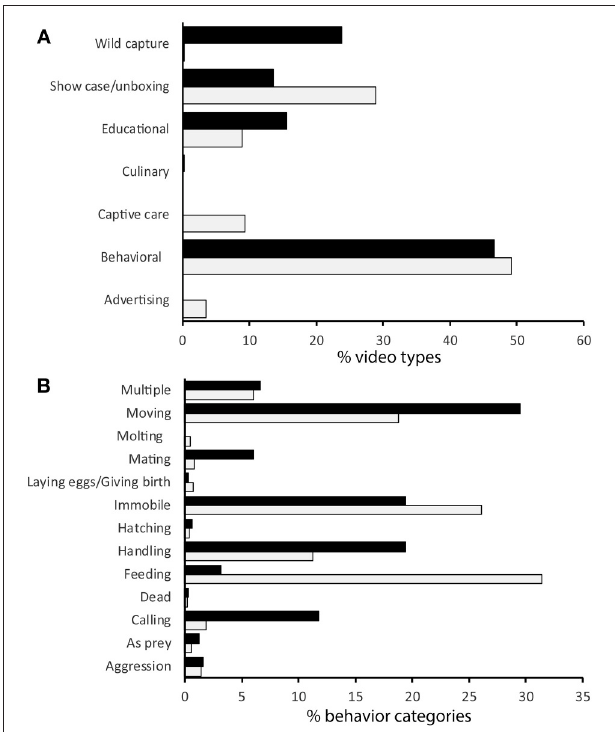
FIGURE 3 | Percentage values of (A) video types and (B) behavior categories exhibited by amphibians in captive (gray bars; n = 847) or wild (black bars; n = 315) YouTube